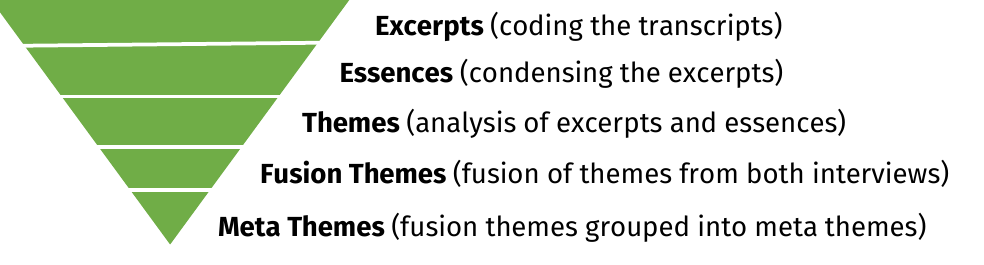
Figure 1. The Analysis Process.